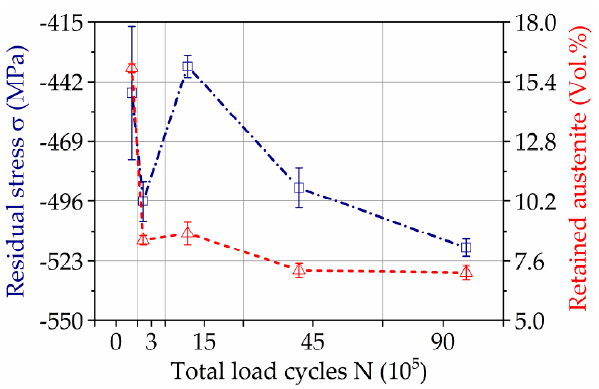
Figure 11. Residual stresses and amount of retained austenite, measured by x-ray diffraction analysis for the different wear conditions.